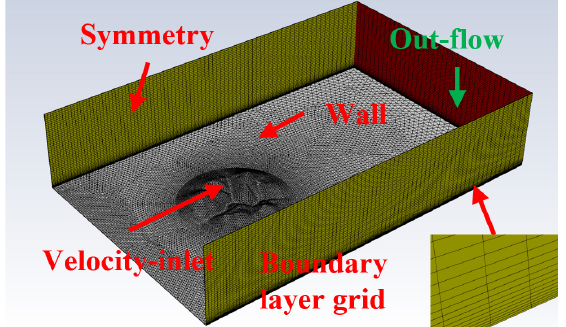
Figure 4. Schematic diagram of grid and boundary.